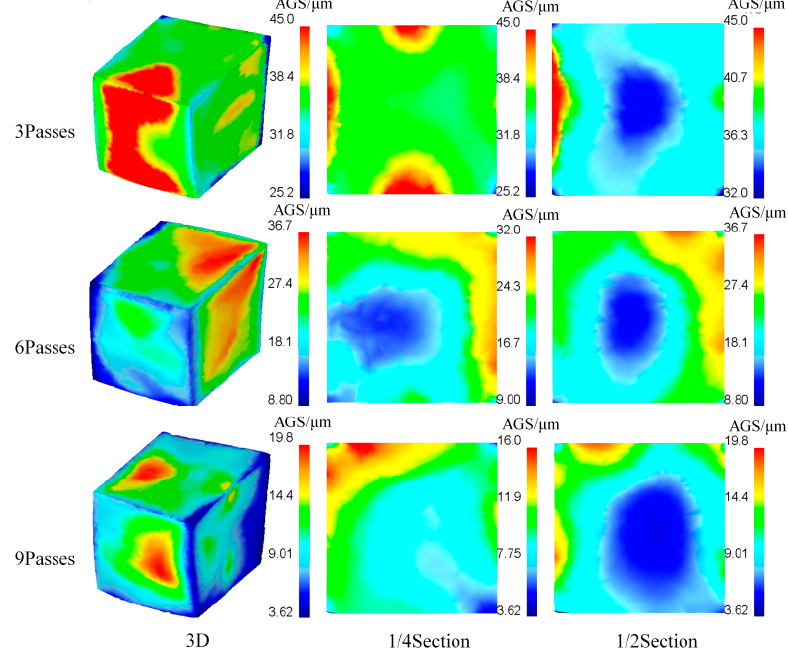
Figure 13. Forging of three to nine passes for recrystallized grain size cloud map at 800 ◦ C. Figure 14 shows the dynamic recrystallization volume fraction cloud diagram of forging from ◦ three to nine passes at 900 C. From the figure, the dynamic recrystallization volume fraction of the forging was symmetrically distributed and could be divided into three deformation zones: di ffi cult, easy, and free deformation. The equivalent strain was minimized on the outer surface due to the mold constraint. Therefore, the recrystallization degree in this area was relatively low, the area with the largest recrystallization was approximately 50%, and some areas were not recrystallized. In the interior of the forging, because it was not a ff ected by the mold friction, the equivalent strain was